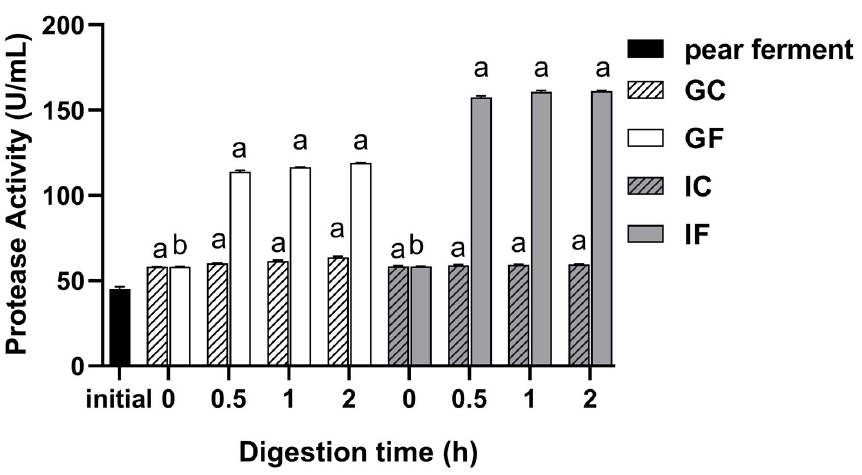
Figure 3. Changes of protease activity of ‘Xuehua’ pear ferment during the simulated gastric and intestinal digestion in vitro. Different letters indicate significant differences in the same group under different digestion times ( p < 0.05). Data shown as means ± SD of three replicates ( n = 3).